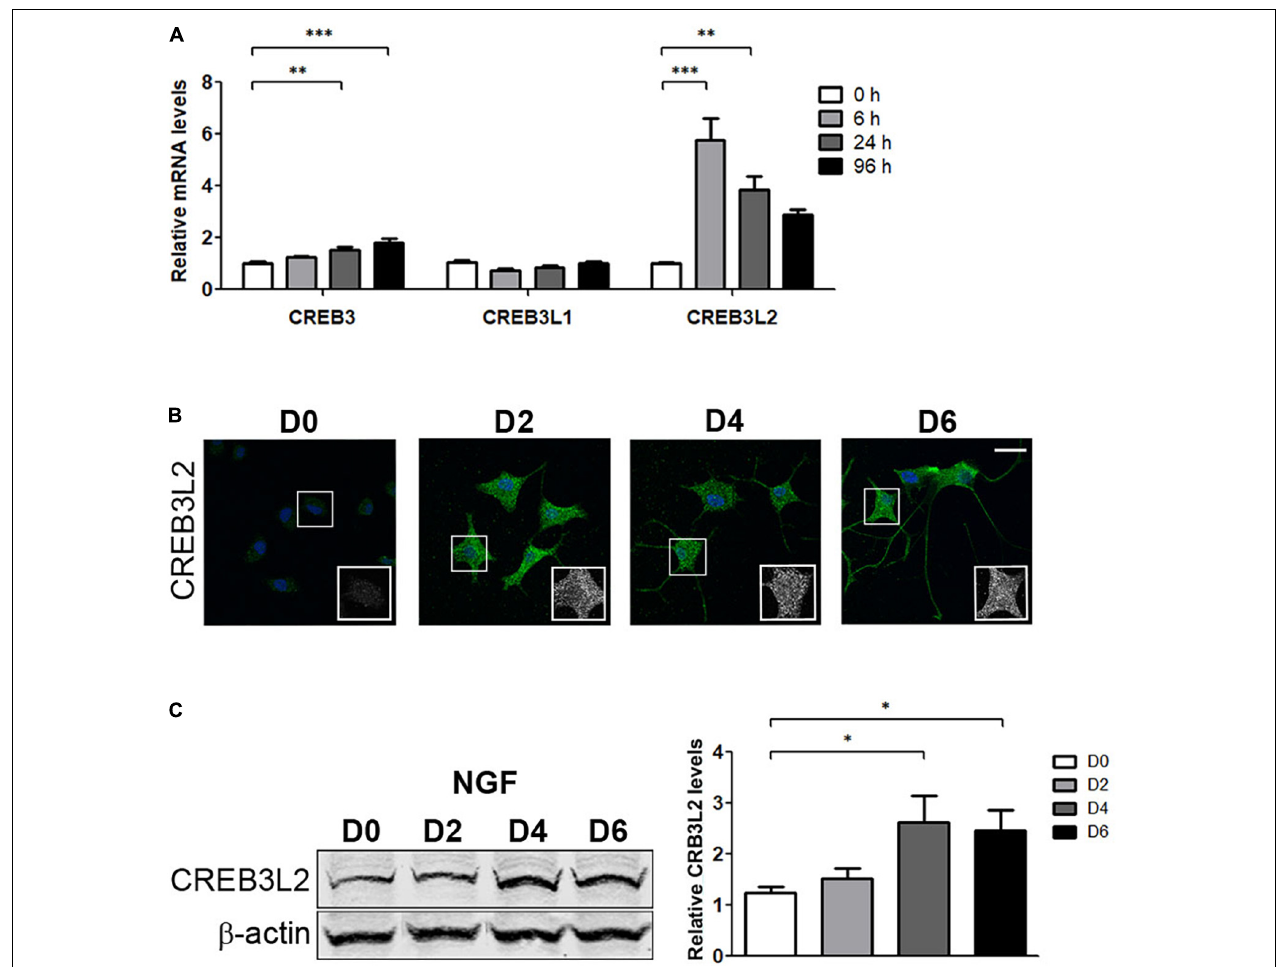
FIGURE 2 | Effect of NGF on CREB3 transcription factor expression. PC12 cells differentiated with NGF at the indicated times. (A) Quantification of CREB3, CREB3L1, and CREB3L2 mRNA levels by qRT-PCR performed with total RNA. The results were normalized to the levels of TBP and expressed according to the 2 − (cid:49)(cid:49) Ct method relative to the expression level of each gene in untreated cells (0 h, set as 1). (B) Representative immunofluorescence staining of CREB3L2 in PC12 cells at the indicated times of NGF incubation. Nuclei were stained with Hoechst (blue). Insets show the ROI (white square) magnification from each image. Scale bar: 20 µ m. (C) Left panel: Representative Western blot assays (detecting the CREB3L2 N-terminal domain or cleaved fragment) performed with cell extracts obtained from PC12 cells treated with NGF during the indicated times. Right panel: Densitometric quantification of CREB3L2 protein shown in left normalized to β -actin. Values represent fold change relative to protein levels in untreated cells (D0). Bars represent the mean ± SEM of three independent experiments carried out in triplicates. Statistical data analysis was performed using ANOVA test, followed by Bonferroni multiple comparison post-test, considering statistically significant a value of p < 0.05 ( ∗ p < 0.05; ∗∗ p < 0.001; ∗∗∗ p <